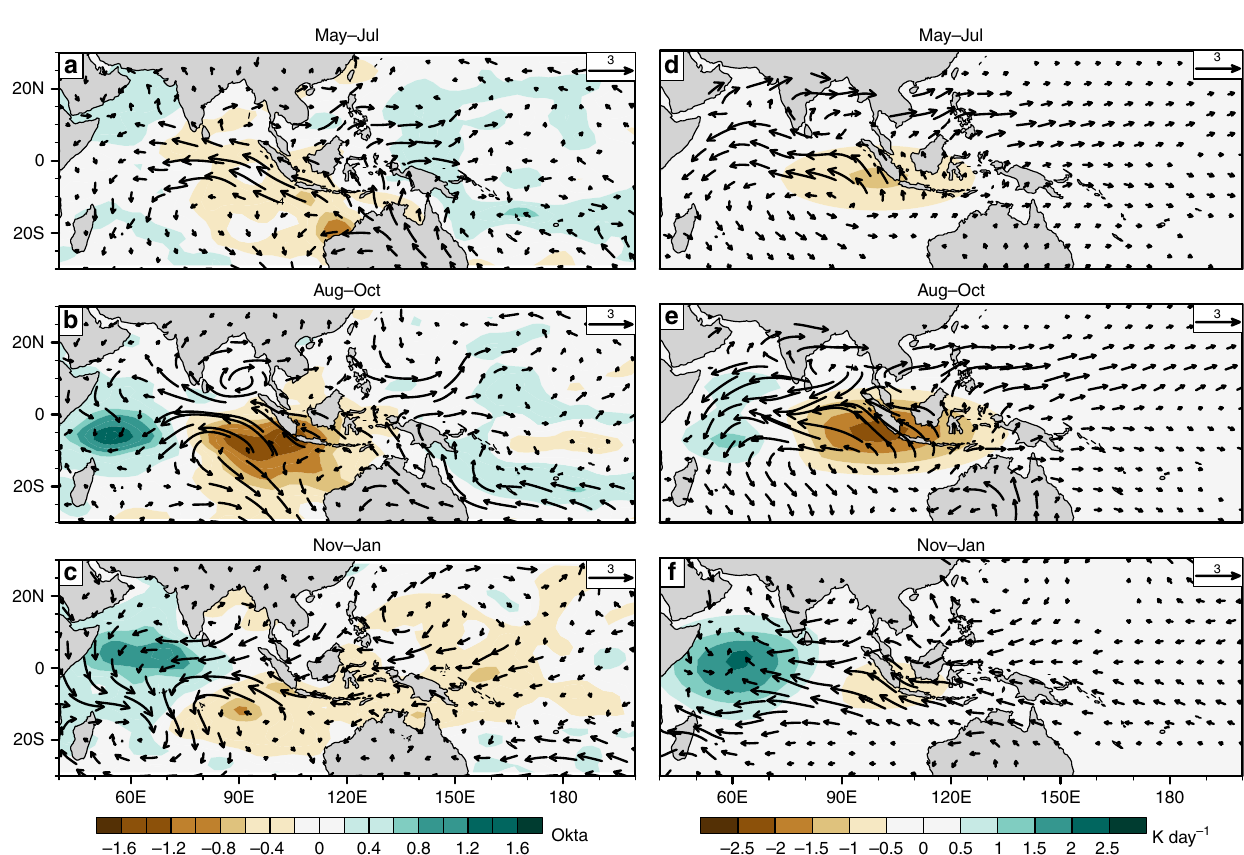
Fig. 5 Surface wind anomalies during IOD from an observational estimate and simulations. We estimated the impact of IOD on surface wind anomalies (left) by regressing observed wind anomalies from 1958 to 2015 onto the Dipole Mode Index (DMI) and Nino3.4 SST anomaly time series. The vectors show the partial regression coef fi cients of wind anomalies with DMI, controlling for Nino3.4, for a May — July, b August — October, and c November — January. The shaded contours on the left are for marine cloudiness, which were analyzed in the same way. The brown-colored contours in ( a – c ) mean less cloudiness (and by inference, less rainfall), while green colors indicate more cloudiness (more rainfall). The right panels are for the same seasons as the left, but they show surface wind anomalies from a simulation. The synthetic thermal forcing (shaded contours in d – f ) that was used to drive the atmospheric model mimics the patterns of marine cloudiness anomalies shown in ( a – c ); anomalously low thermal heating (brown contours in d – f ) was prescribed in regions where anomalously low rainfall is noted in the observations ( a – c ); enhanced thermal heating (green shading in d – f ,) in regions with anomalously high rainfall. A partial regression measures the amount by which the dependent variable (e.g., surface wind anomaly) changes when one of the independent variables (here, DMI) is increased by one unit while keeping the other independent variable (here, Nino3.4) constant (or controlled). The maps in the fi gure were rendered with the NCAR Command Language software (https://doi.org/10.5065/D6WD3XH5) from the Global Self-consistent, Hierarchical, High-resolution Geography Database (GSHHG). The GSHHG is available online at Fig. 5a – c for marine cloudiness (shaded contours) and surface winds (vectors). Paci fi c wind anomalies change considerably during IOD evolution, alongside Indian Ocean convective anomalies. Before the mature phase of IOD, cloudiness anomalies in the eastern Indian Ocean are considerably stronger than in the western Indian Ocean; these are associated with westerly anomalies in the western equatorial Paci fi c. The Paci fi c wind